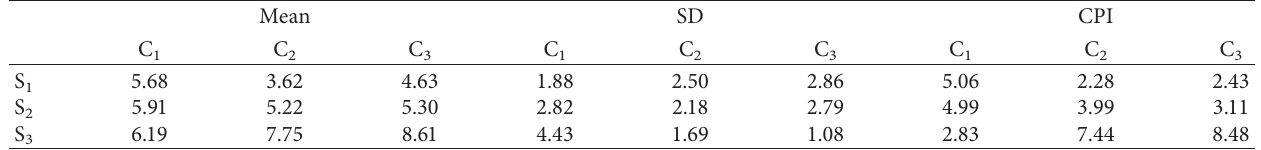
Table 6: Profile analysis of the cutters under three specimens